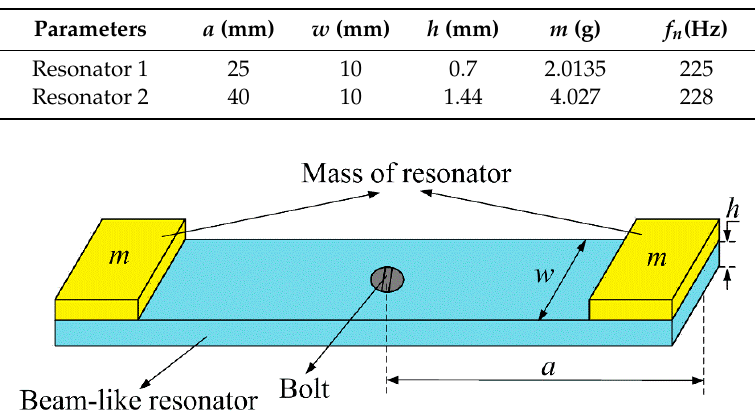
Table 1. Physical parameters of beam-like resonator samples.